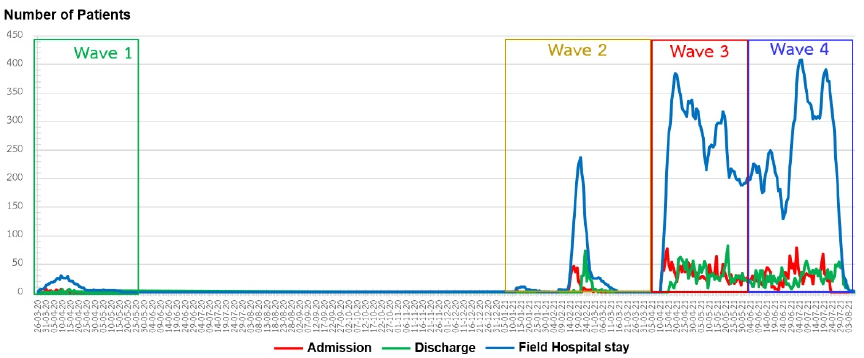
Figure 1. Daily number of new field hospital admission with COVID-19, field hospital length of